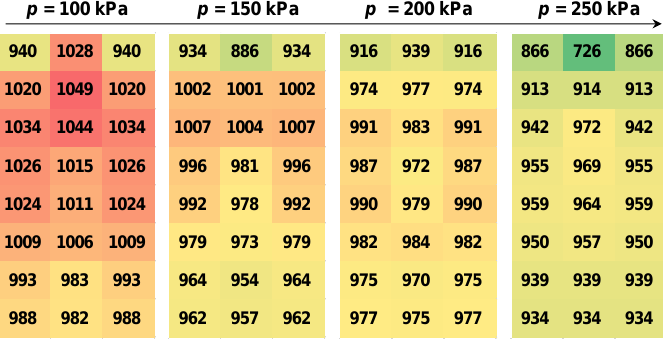
Figure 6. Temperature distributions for various atomizing air pressures at S = 4.56 and φ = 0.8.